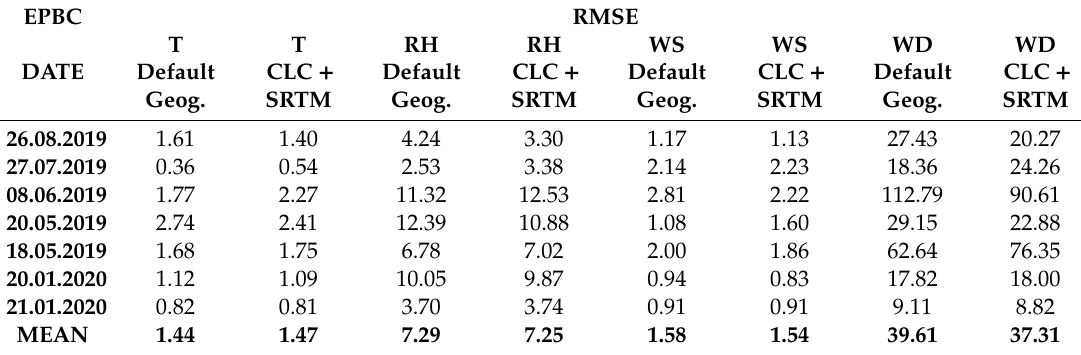
Table 8. RMSE for temperature (T), relative humidity (RH), wind speed (WS), and wind direction (WD) for the analyzed synoptic situations at EPBC, the period from 10:00 UTC to 15:00 UTC. EPBC